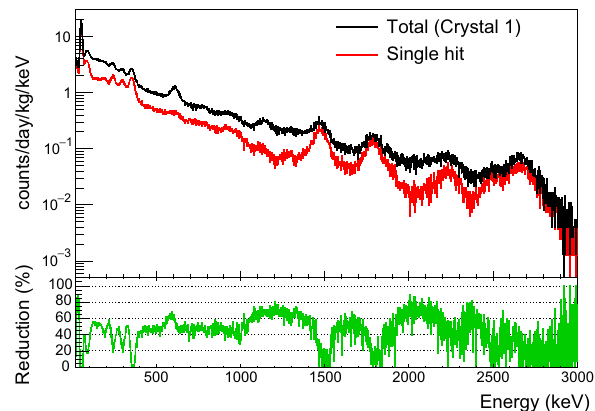
Fig. 24 A schematicview ofthe detectorgeometry. The copper encap- sulation is shown in white in the middle, the acrylic crystal support structure is shown in red, the copper box is shown in yellow, the lead castle is shown in red, and the muon panels are shown in